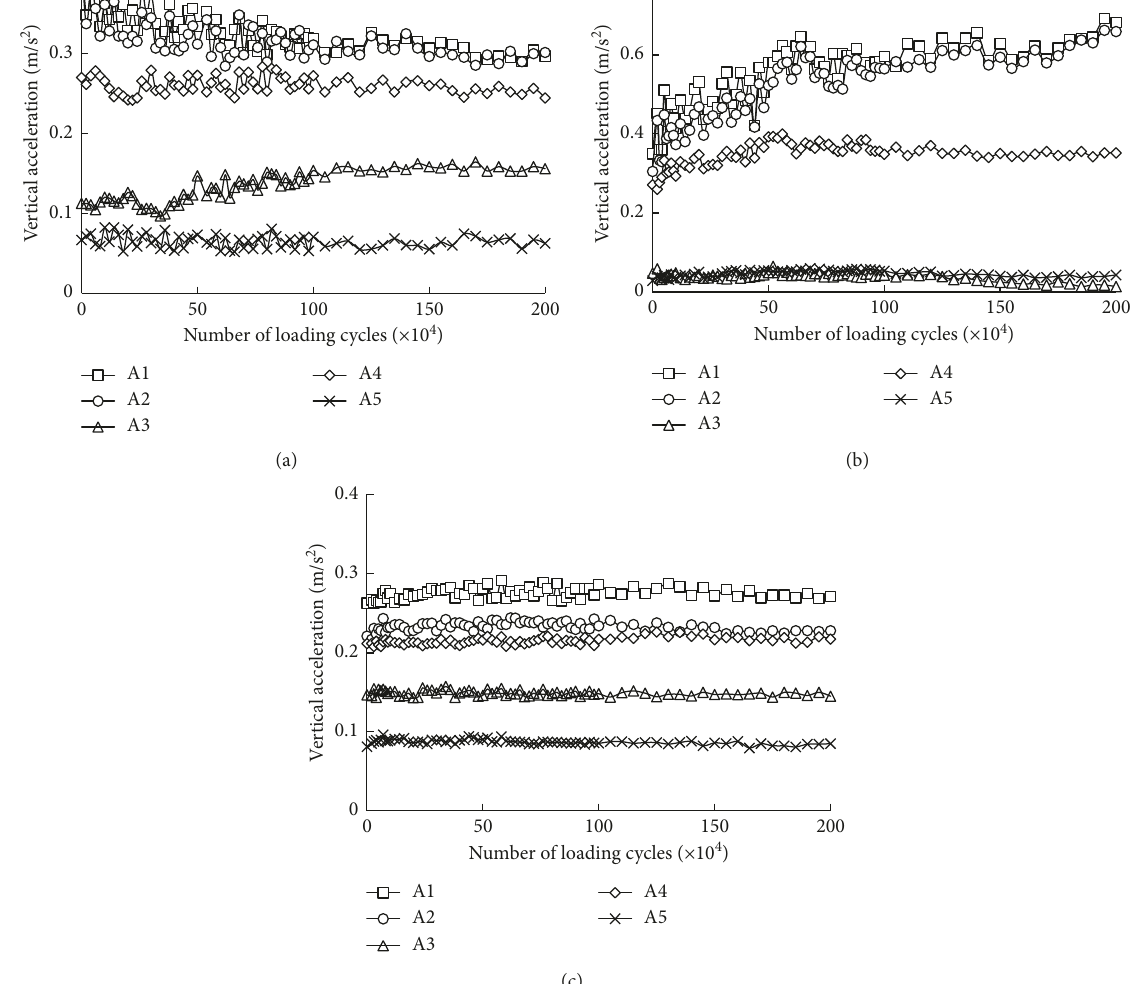
Figure 9: The variation of vertical vibration acceleration of the model with the number of loading cycles. (a) The upper layer of the subgrade bed in normal condition (stage 1). (b) The upper layer of the subgrade bed in saturation (stage 2). (c) The model after mud pumping reinforcement (stage